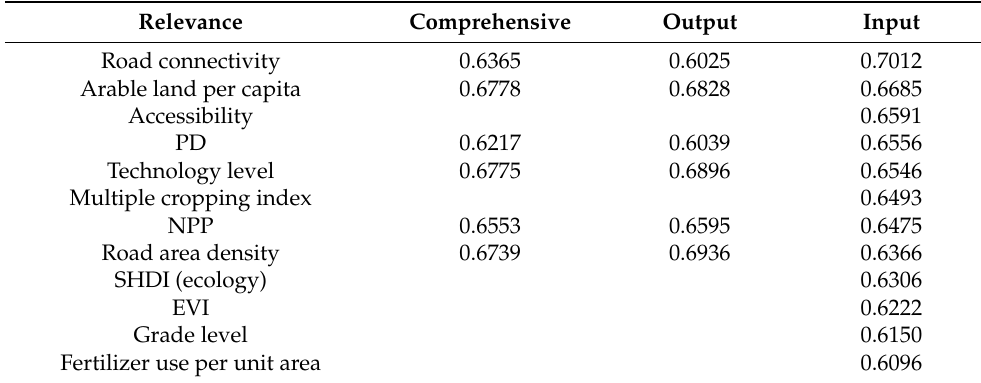
Table 9. Interaction between agricultural production, road infrastructure, and the agricultural eco-environment.